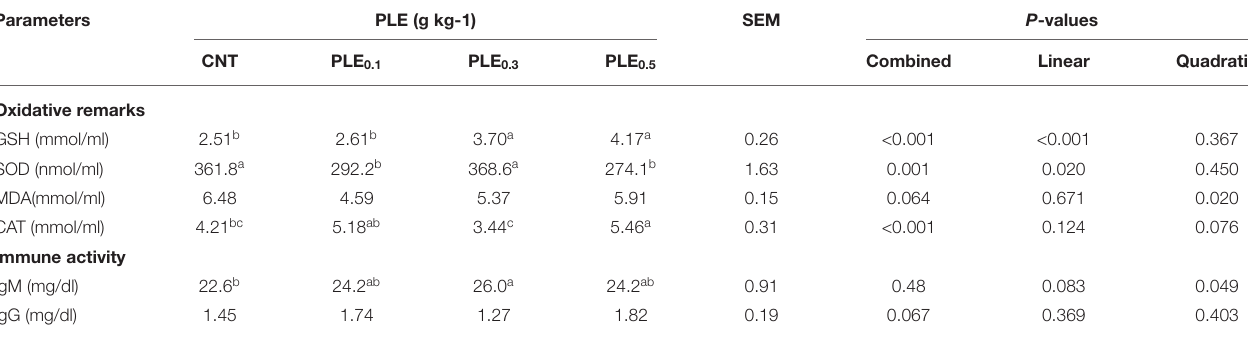
TABLE 7 | Oxidative remarks and immune status of broilers as affected by PLE supplemented diets at different levels.